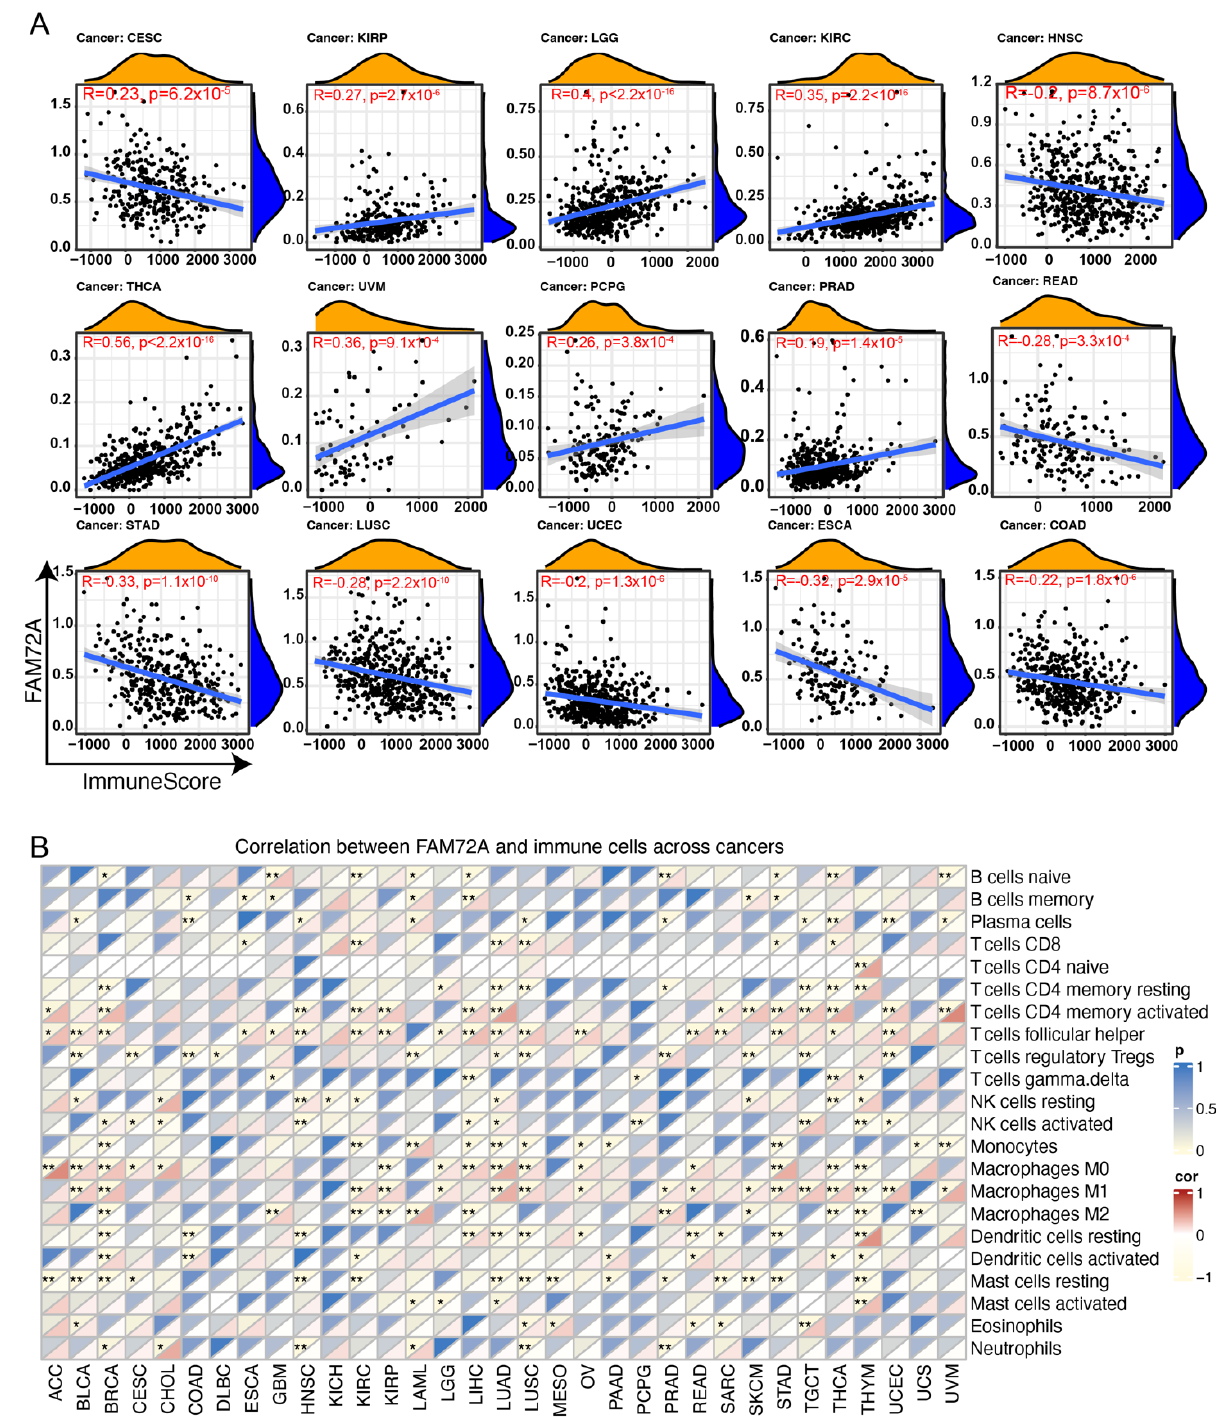
Figure 4. Correlation between the expression of FAM72A and immune cell infiltration in pan-cancer. ( A ). Correlation between the expression of FAM72A and ImmuneScore derived from the Estimation of Stromal and Immune cells in Malignant Tumor tissues using Expression data (ESTIMATE) algorithm. ( B ). Correlation between the expression of FAM72A and proportions of 22 infiltrating immune cell subsets evaluated using the Cell-type identification by Estimating Relative Subsets of RNA Transcripts (CIBERSORT) method. Correlations were determined by the Spearman method. * p < 0.05, and ** p <